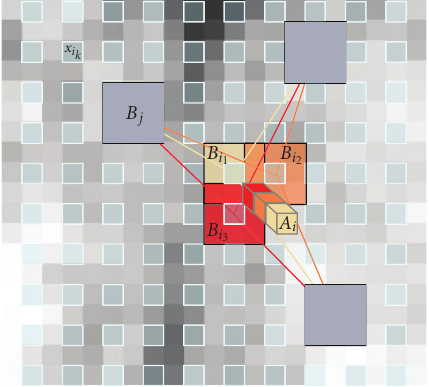
Figure 2: Blockwise NL-means filter. For each block B i , an NL-means-like restoration is performed from blocks voxel x i k B j . In this way, for a voxel x i included in several blocks, several esti- mations are obtained. The restored value of voxel x i is the average of the di ff erent estimations stored in vector A i . In this example, α = 1, n = 2, and | A i | =